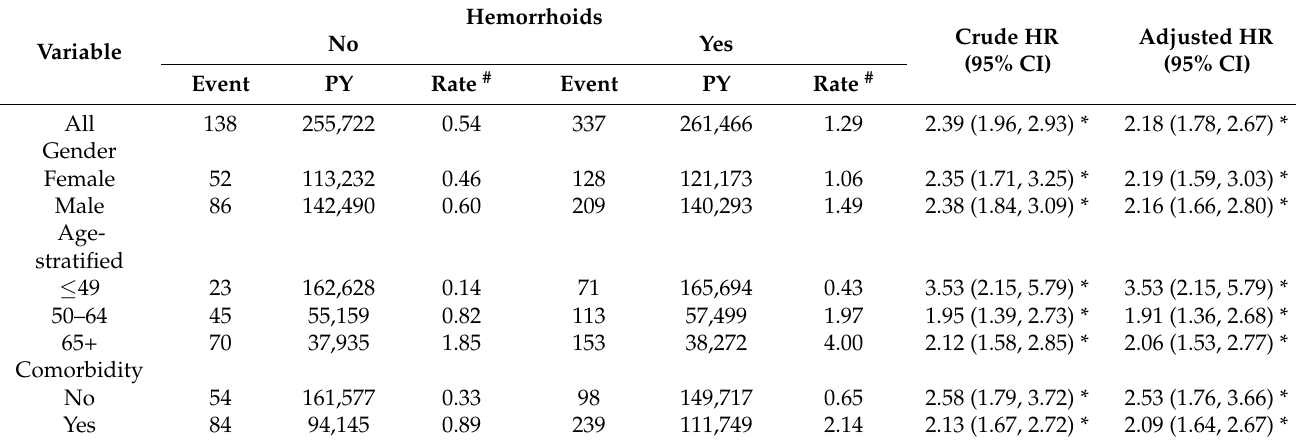
Table 2. Incidence and hazard ratio of colorectal cancer compared between the cohorts with and without hemorrhoids by gender, age, and comorbidity.